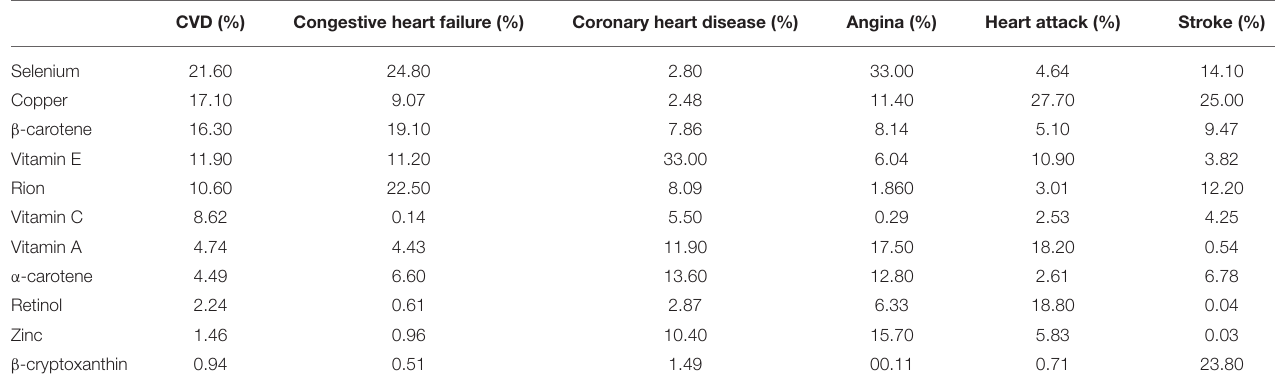
TABLE 4 | WQS regression analysis of 11 antioxidant micronutrients weights of total CVD and specific CVDs.